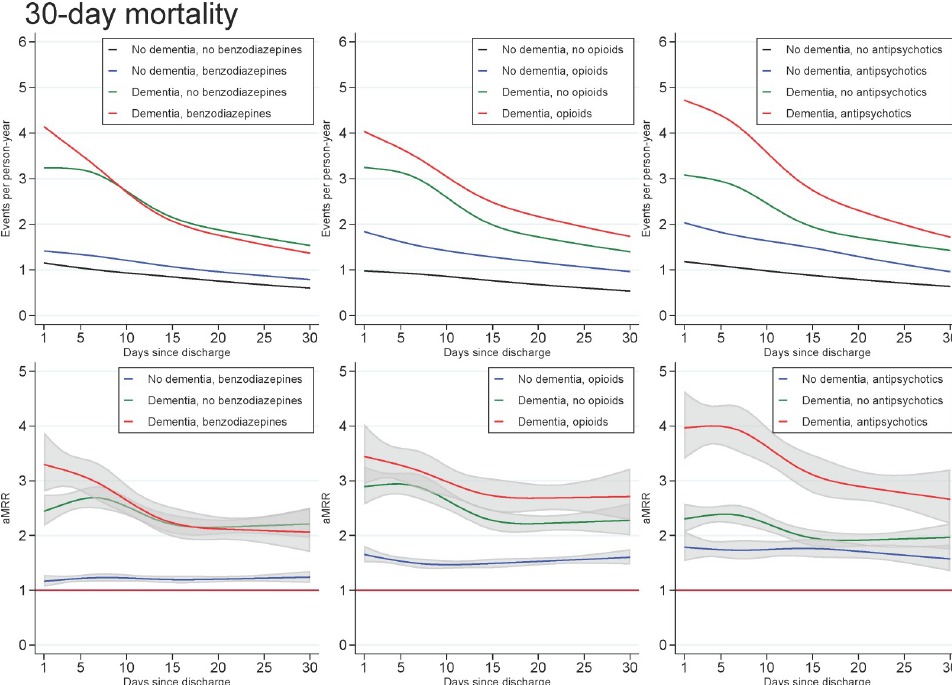
Fig 2. Unadjusted mortality rates and adjusted mortality rate ratios for patients with dementia, (without medication use), patients with use of benzodiazepines, opioids or antipsychotics (without dementia), and patients with both or neither exposures, plotted as a function of days since discharge. Abbreviations: aMRR: adjusted mortality rate ratios. MRRs adjusted for sex, age, calendar period, cohabitation status, length of stay, type of pneumonia diagnosis, time since discharge, somatic comorbidities, psychiatric comorbidities, and alcohol/substance